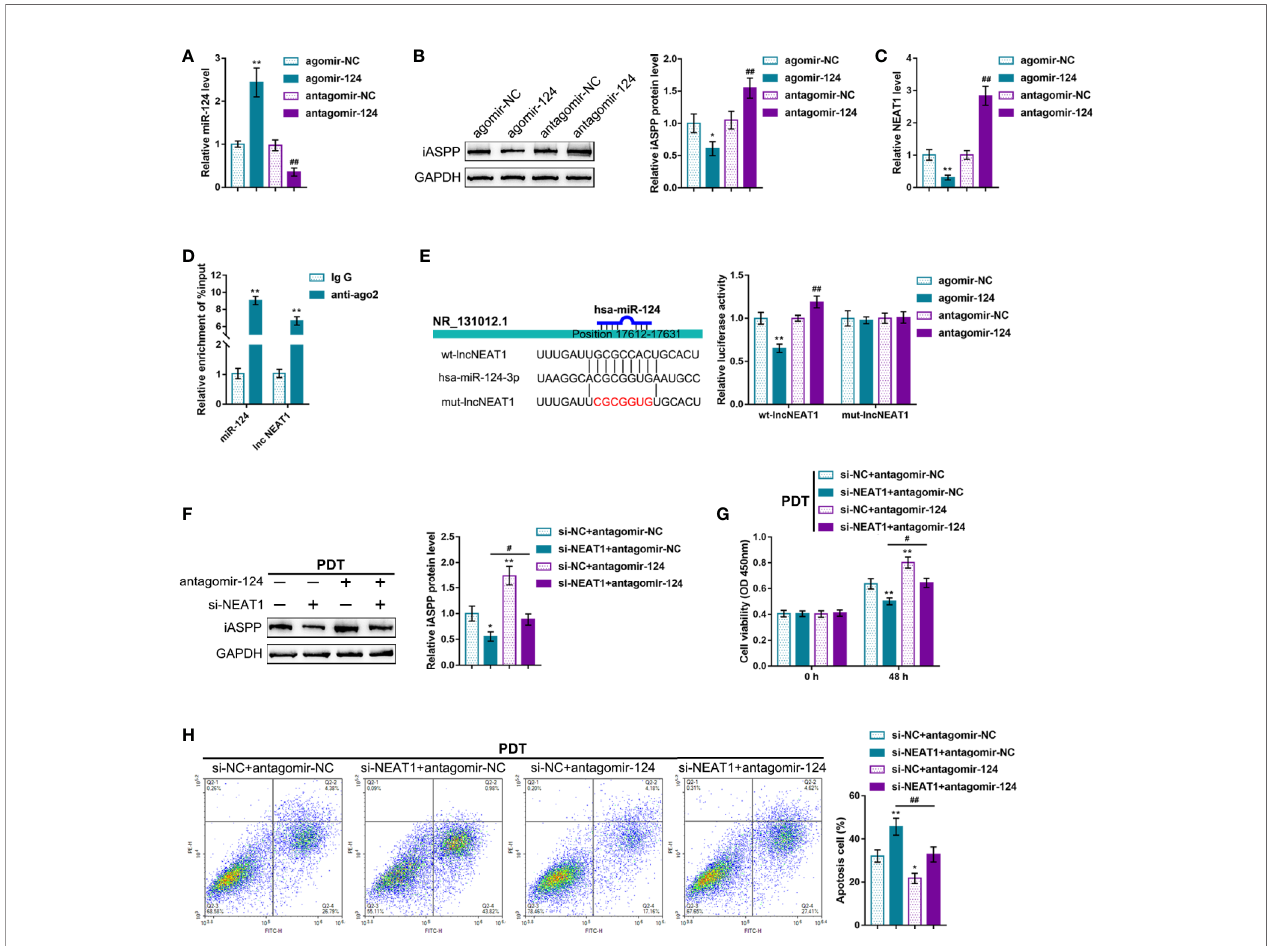
FIGURE 3 | NEAT1 promoting CRC cell resistance to PDT treatment through targeting miR-124. (A) miR-124 overexpression or inhibition was achieved in HCT116 cells by transfecting agomir-124 or antagomir-124; agomir-NC or antagomir-NC was transfected as a negative control. The transfection ef fi ciency was con fi rmed by qRT-PCR. (B) HCT116 cells were transfected with agomir-124 or antagomir-124 and examined for the protein levels of iASPP by Immunoblotting. (C) HCT116 cells were transfected with agomir-124 or antagomir-124 and examined for the levels of NEAT1 by RT-PCR. (D) RIP assay was performed using anti-IgG or anti-Ago2. The levels of miR-124 and NEAT1 in immunoprecipitate were determined by qRT-PCR. (E) Dual-luciferase reporter assay was performed by constructing wild-type and mutant-type lncNEAT1 reporter vectors and co-transfecting the reporter vectors in 293T cells with agomir-124 or antagomir-124. The luciferase activity was determined. Then, HCT116 cells were co-transfected with si-NEAT1 and antagomir-124, treated or non-treated with PDT, and examined for the protein levels of iASPP by Immunoblotting (F) , cell viability by CCK-8 assay (G) , and cell apoptosis by fl ow cytometry (H) . * P < 0.05, ** P < 0.01, # P < 0.05, ## P <